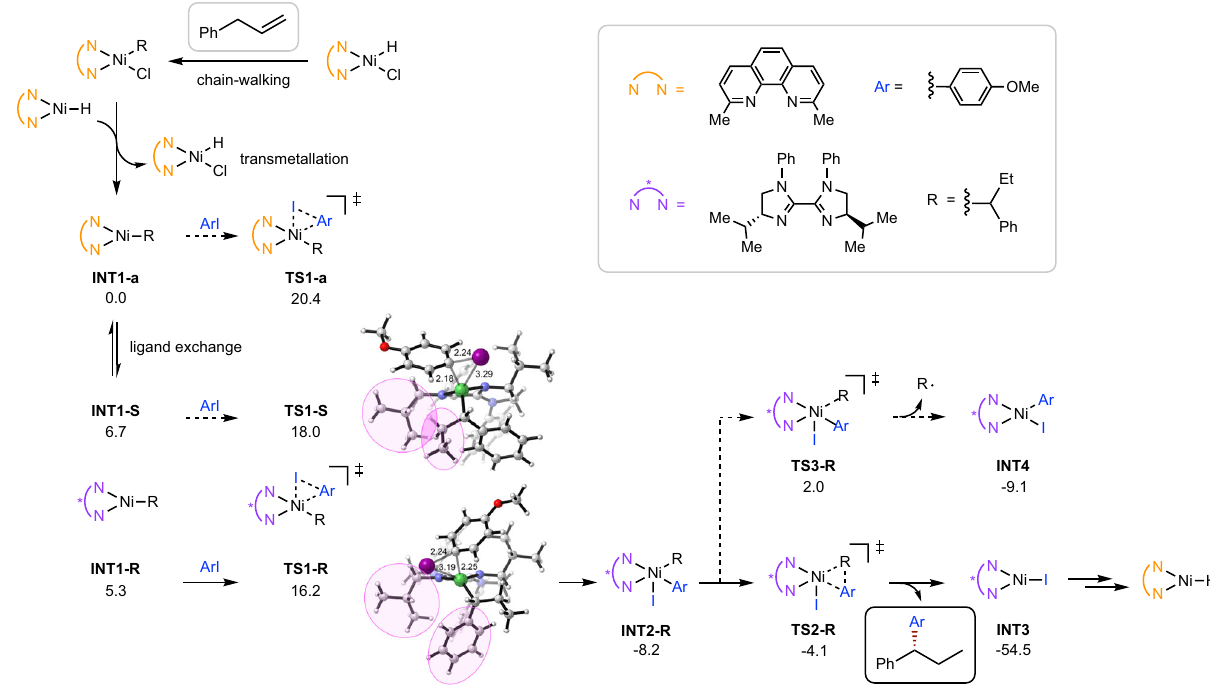
Fig. 7 Computational study of the asymmetric arylation. Computed at SMD(DCM)-(U)M06/6-311 + G(d,p)[SDD for Ni and I]//(U)B3LYP/6-31G(d) [LANL2DZ for Ni and I]. Values are relative Gibbs free energies in kcal/mol. Coloured atoms in graphics: grey, C; white, H; red, O; blue, N; green, Ni; purple, I. Distances are in